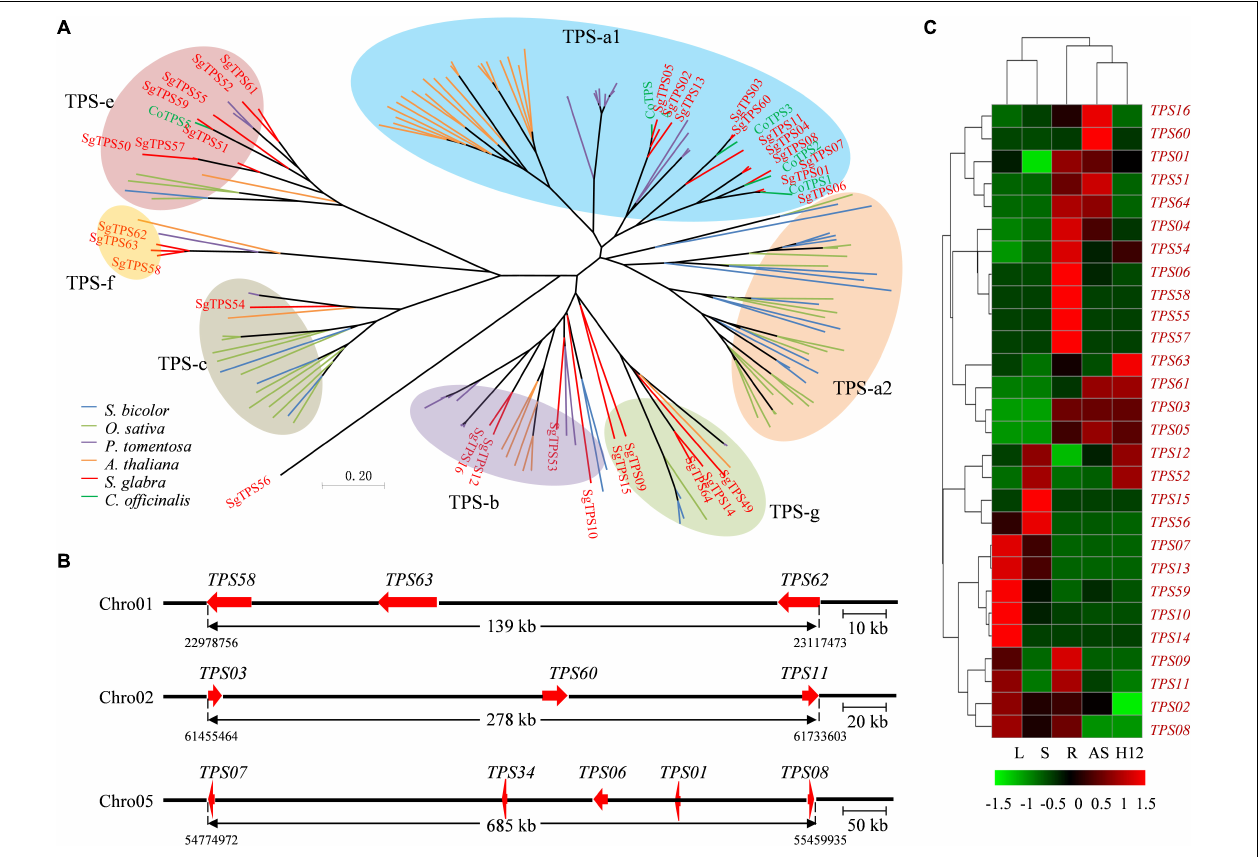
FIGURE 4 | Phylogenetic analyses, gene distribution and expression profiles of terpene synthase genes (TPSs). (A) Phylogenetic analysis of putative full-length TPSs from S. glabra , S. bicolor , O. sativa , P. tomentosa , A. thaliana , and C. officinalis . The TPSs from S. glabra were indicated in red. (B) Distribution of SgTPS gene clusters across different chromosomes. Arrows indicate the orientation of genes. (C) Heat map of expression patterns of putative full-length SgTPS genes. L, leaf; S, stem from young plants; R, root; AS, stem from adult plants; H12, stem from high oil-yielding